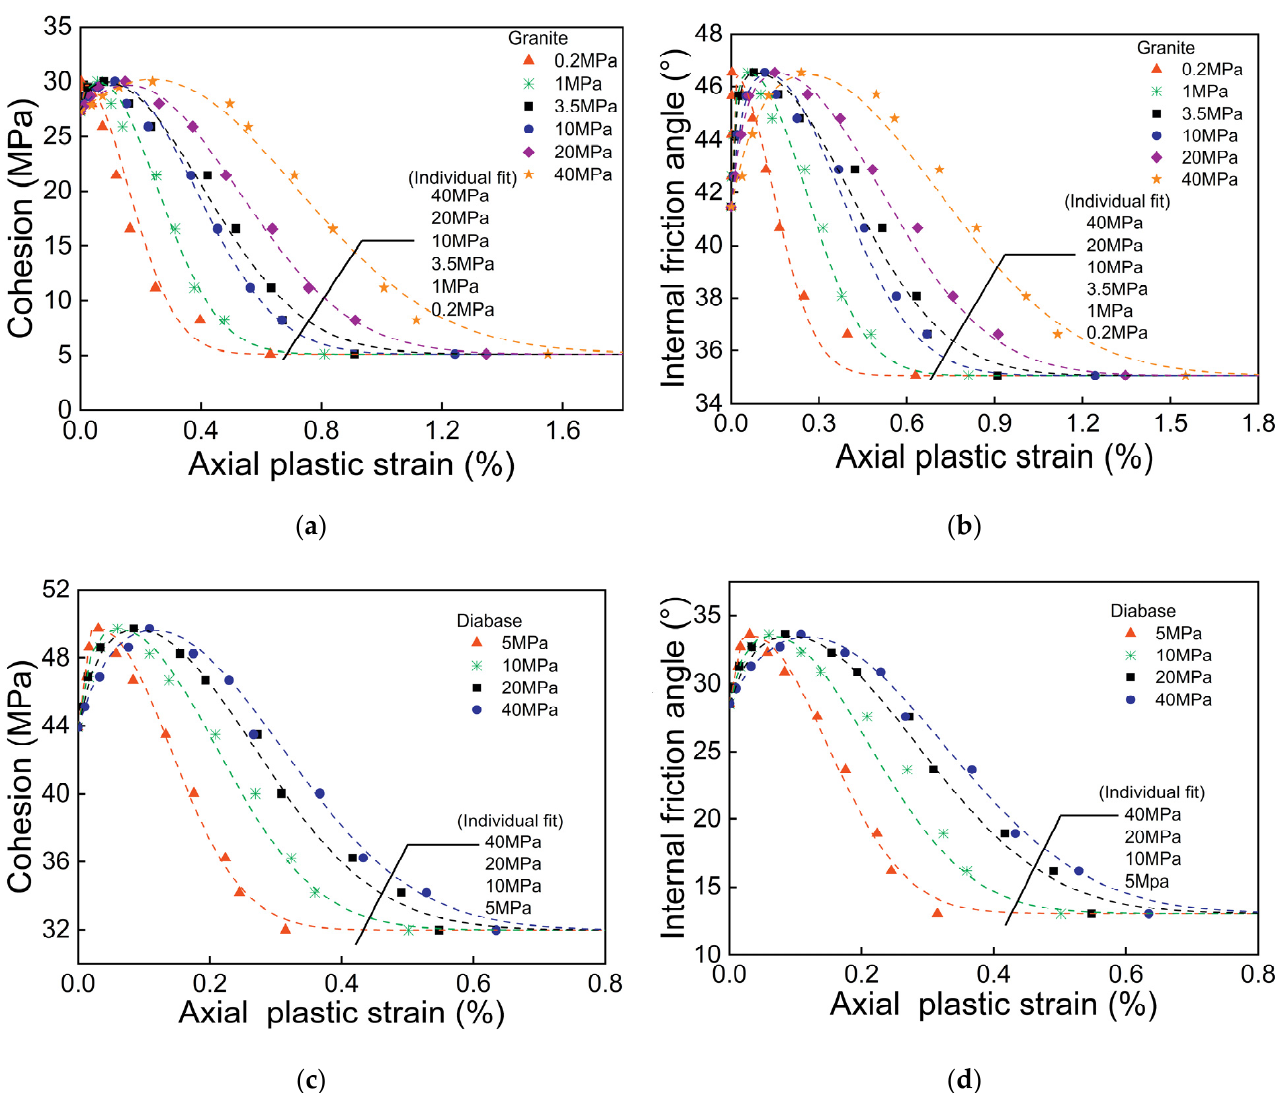
Figure 4. Cohesion/internal friction angle–axial plastic strain relationships of two hard brittle rock types under different confining pressures and their best fits. Data of ( a , b ) are for Beishan granite [26] and those of ( c , d ) are for Danjiangkou diabase [37].